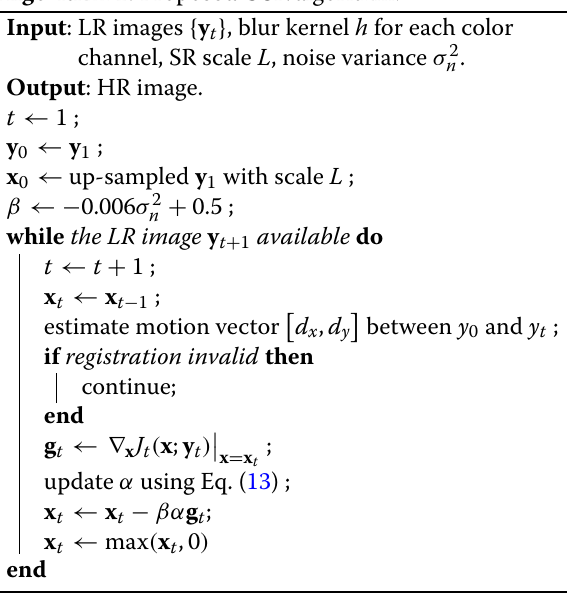
Algorithm 1: Proposed OSR